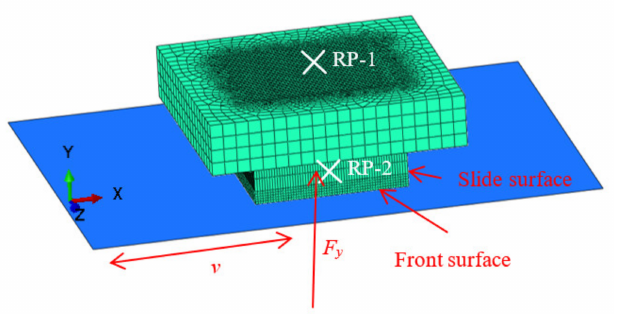
Figure 6. 3D finite element